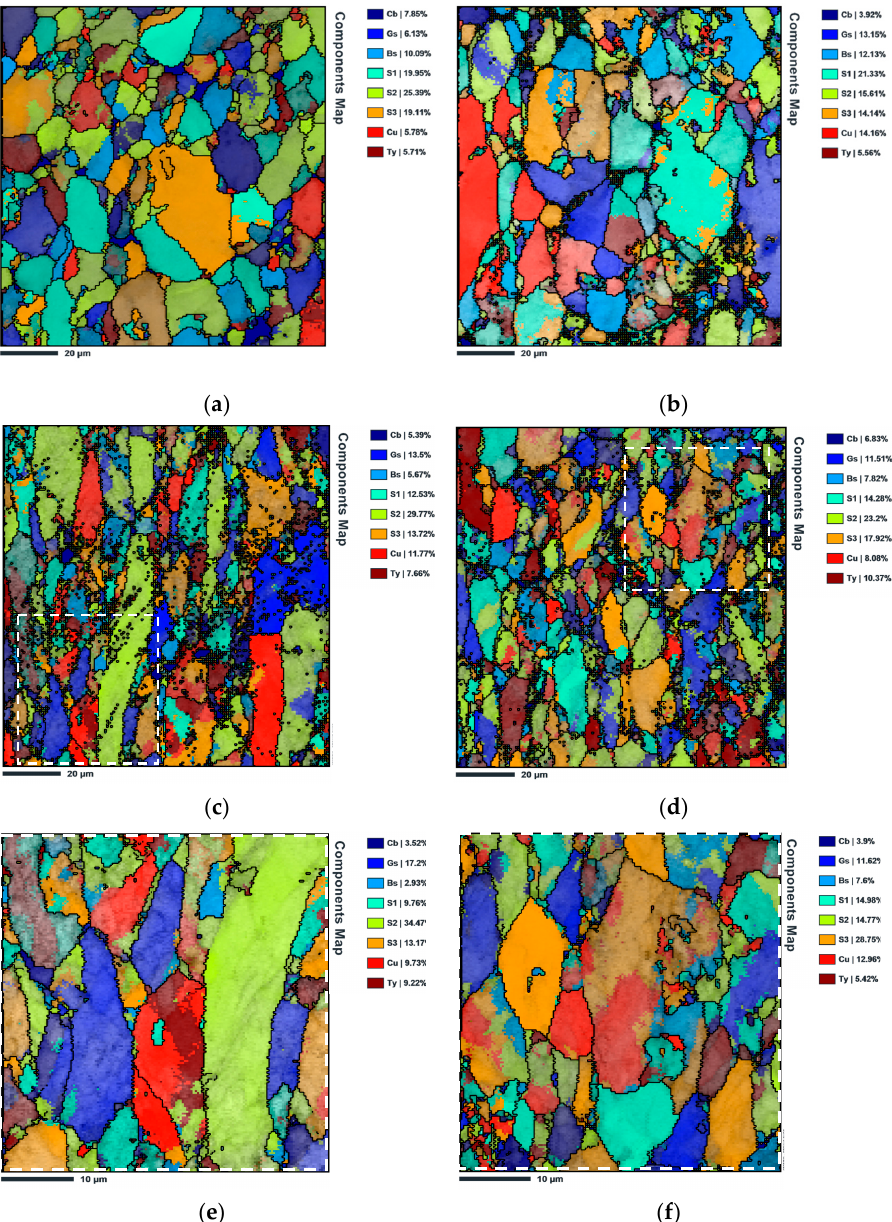
Figure 13. Texture rolling components maps of ( a ) Al cold rolled to 0.11, ( b ) Al/CNT cold rolled to 0.11, ( c , e ) Al cold rolled to 0.36, and ( d , f ) Al/CNT cold rolled to 0.36 analysed with ( c , d ) lower and ( e, f) higher magni fi cation.